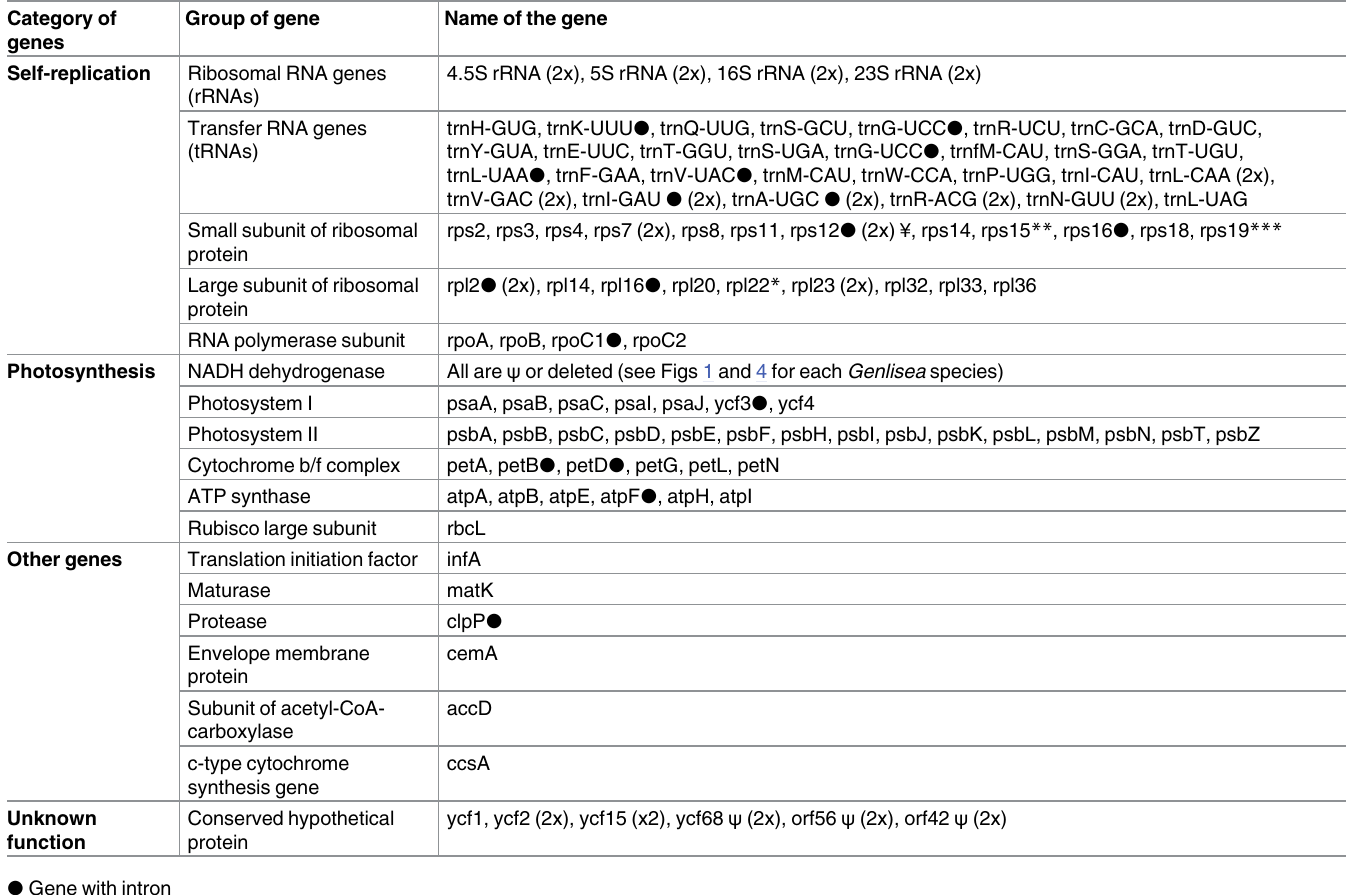
Table 2. Genes in the six Genlisea chloroplast genomes (except G . margaretae ). Category of Group of genes